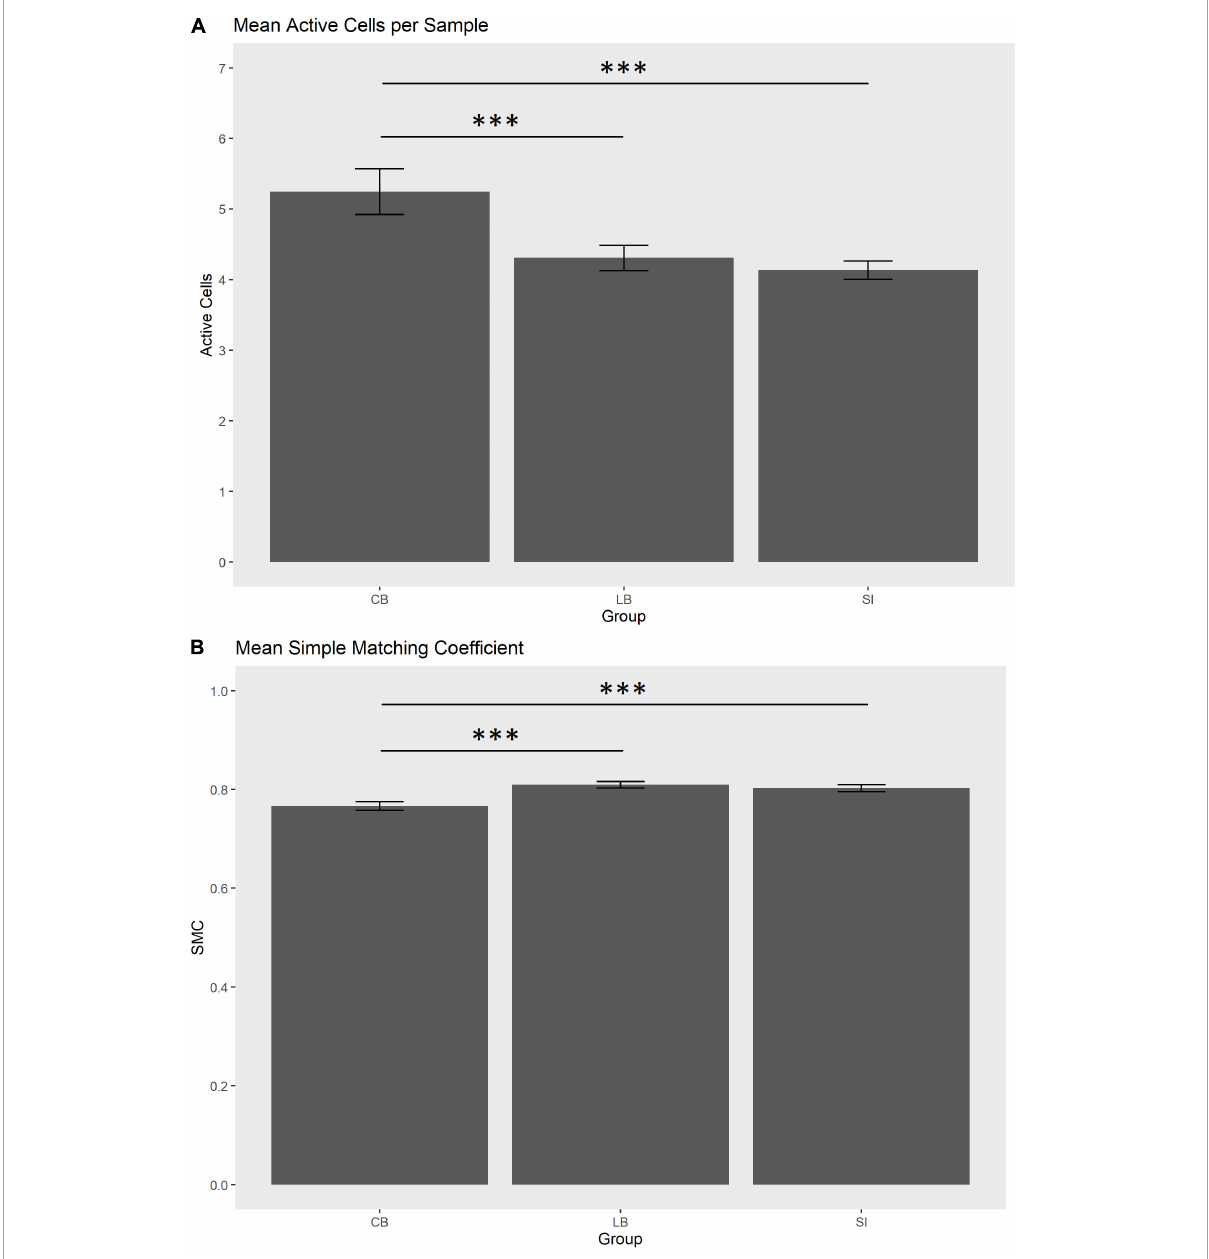
FIGURE3 (A) Mean active cells per sample (0.2 s) in the explored face. (B) Mean simple matching coefficient (SMC) in the explored face. Whiskers indicate SEM. ∗∗∗ p fdr <